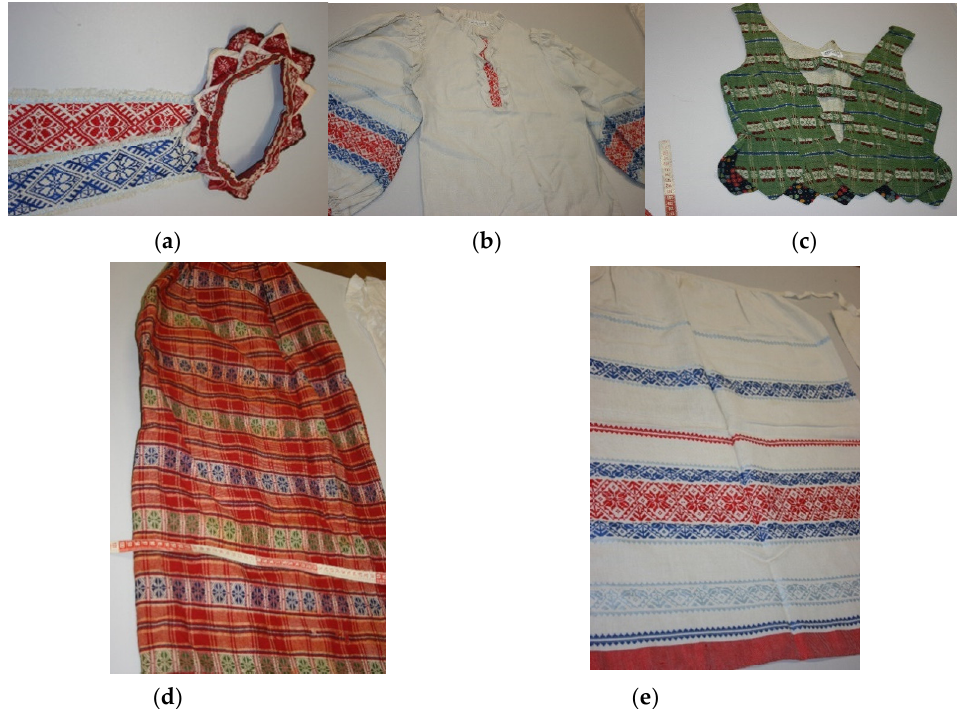
Figure 14. National costume from Aukštaitija in 1935–1940: ( a ) Crown ČDM E6360T; ( b ) shirt ČDM E6357; ( c ) vest ČDM E6358; ( d ) skirt ČDM E6356T; ( e ) apron ČDM E6359.